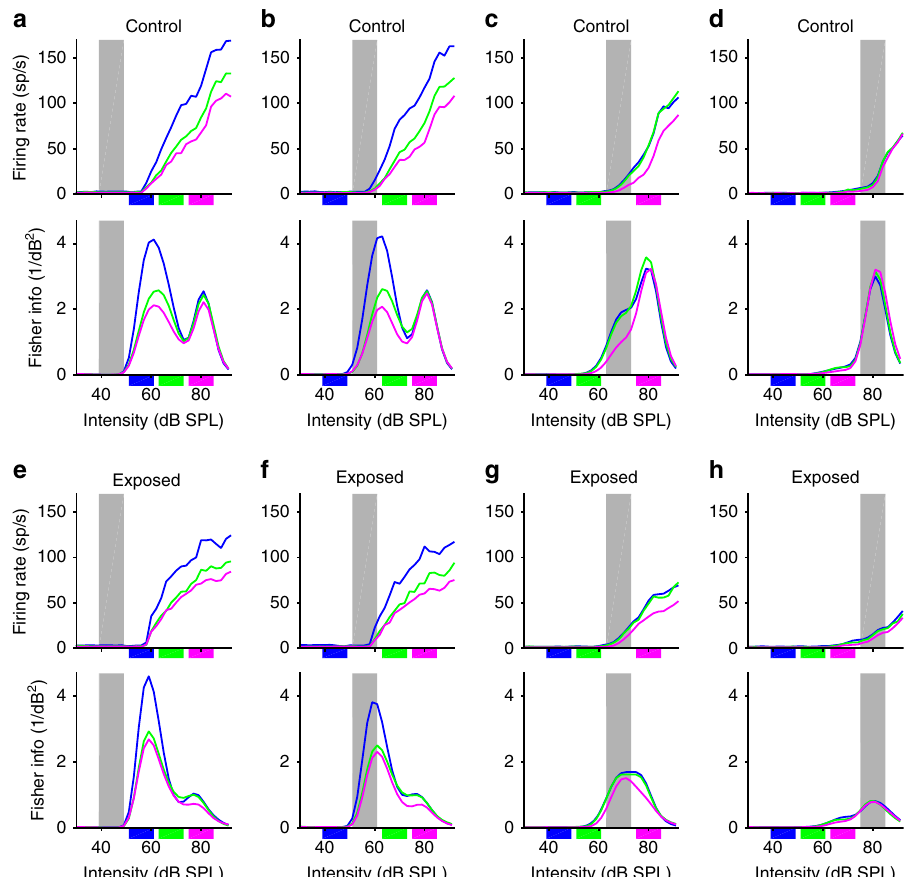
Fig. 4 Neural population rate-vs.-intensity functions and Fisher information (FI) curves. The graphs show population averages of adapted rate-vs.-intensity functions (top panels) and average FI (bottom panels) for the different HPRs. The intensity range of the HPR for which RIFs and FIs are shown is indicated by the grey bar. The colours of the lines denote the context, that is, the other HPR within the switching stimulus, with the corresponding intensity range shown by the small coloured patches. a – d show data from control animals, and e – h show data from exposed